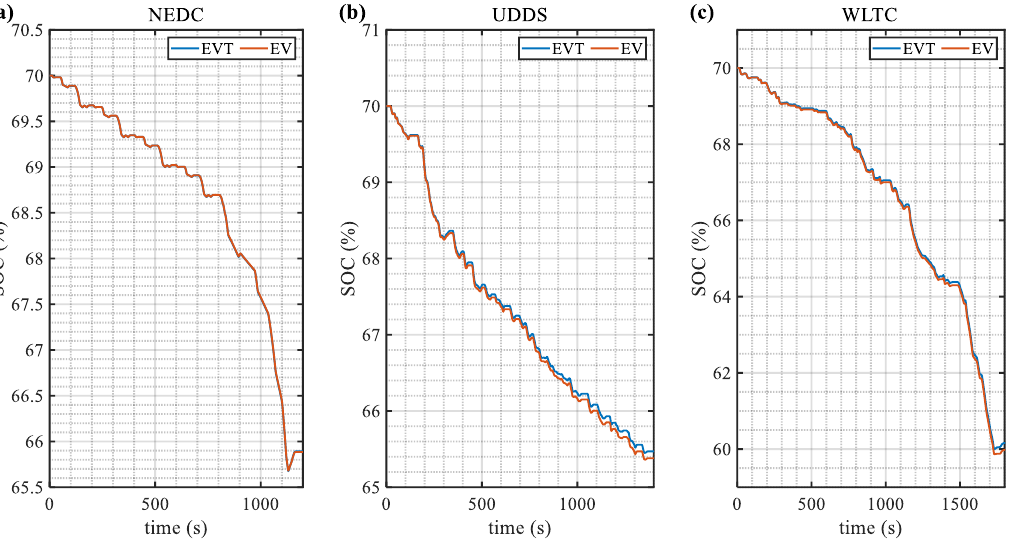
Figure 14. Motor efficiency in three driving cycles: (a) Efficiency under NEDC driving cycle; (b) Efficiency under UDDS driving cycle; (c) Efficiency under WLTC driving cycle.